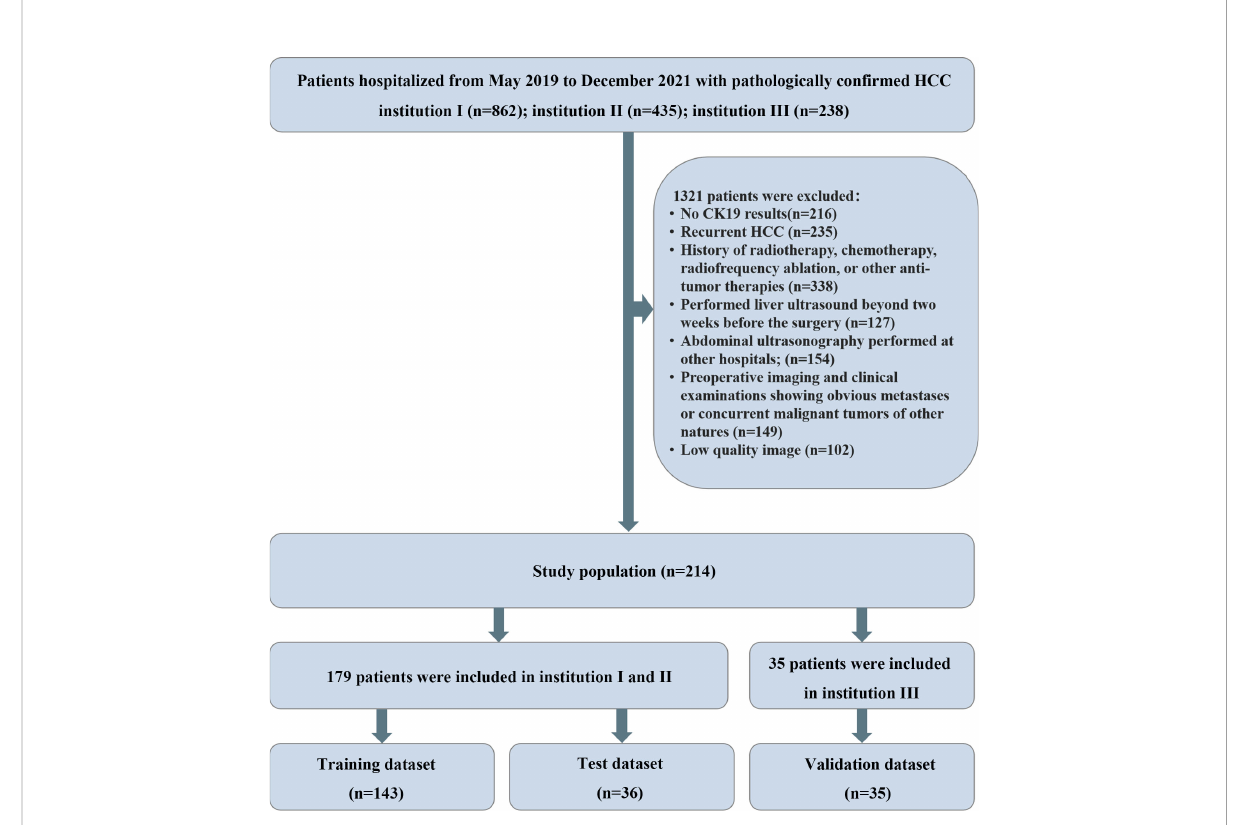
FIGURE 1 Flowchart: Cases were screened and enrolled according to the established exclusion